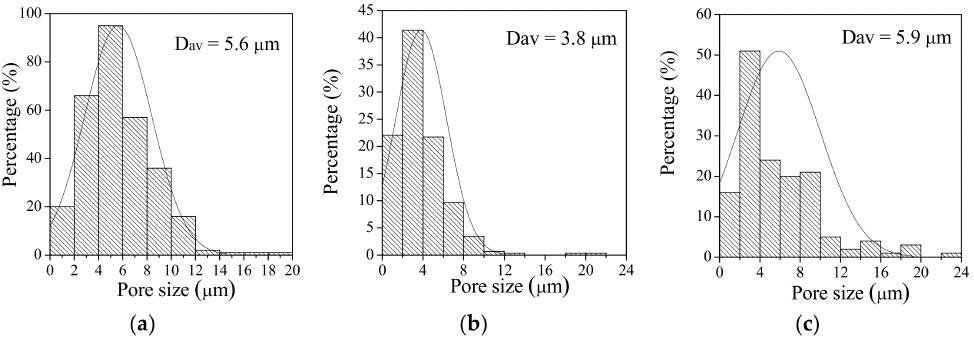
Figure 6. The histograms of the pore distribution by sizes for CaP coatings deposited under different MAO voltages, V: ( a ) − 350; ( b ) − 450; ( c ) − 500.